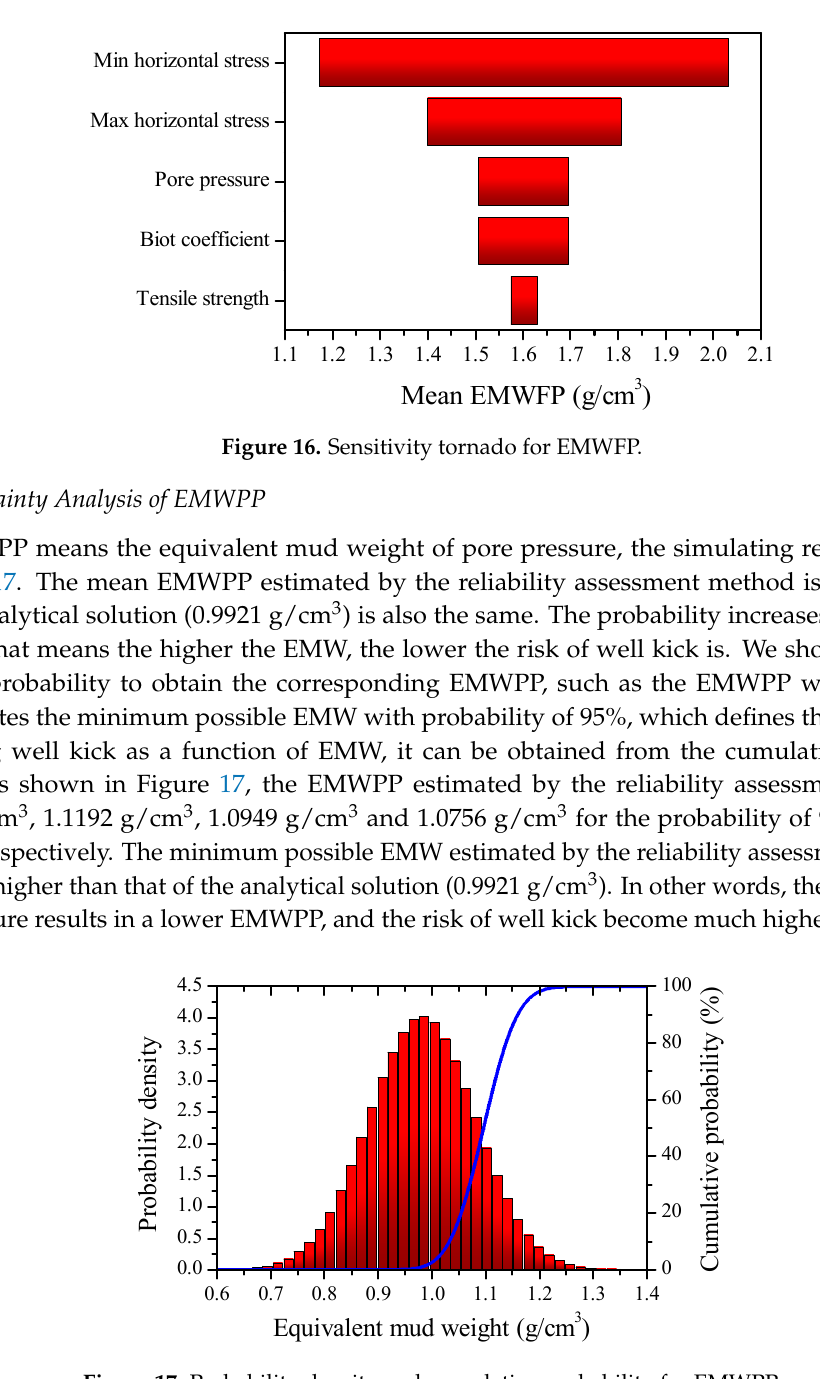
Figure 17. Probability density and cumulative probability for EMWPP.